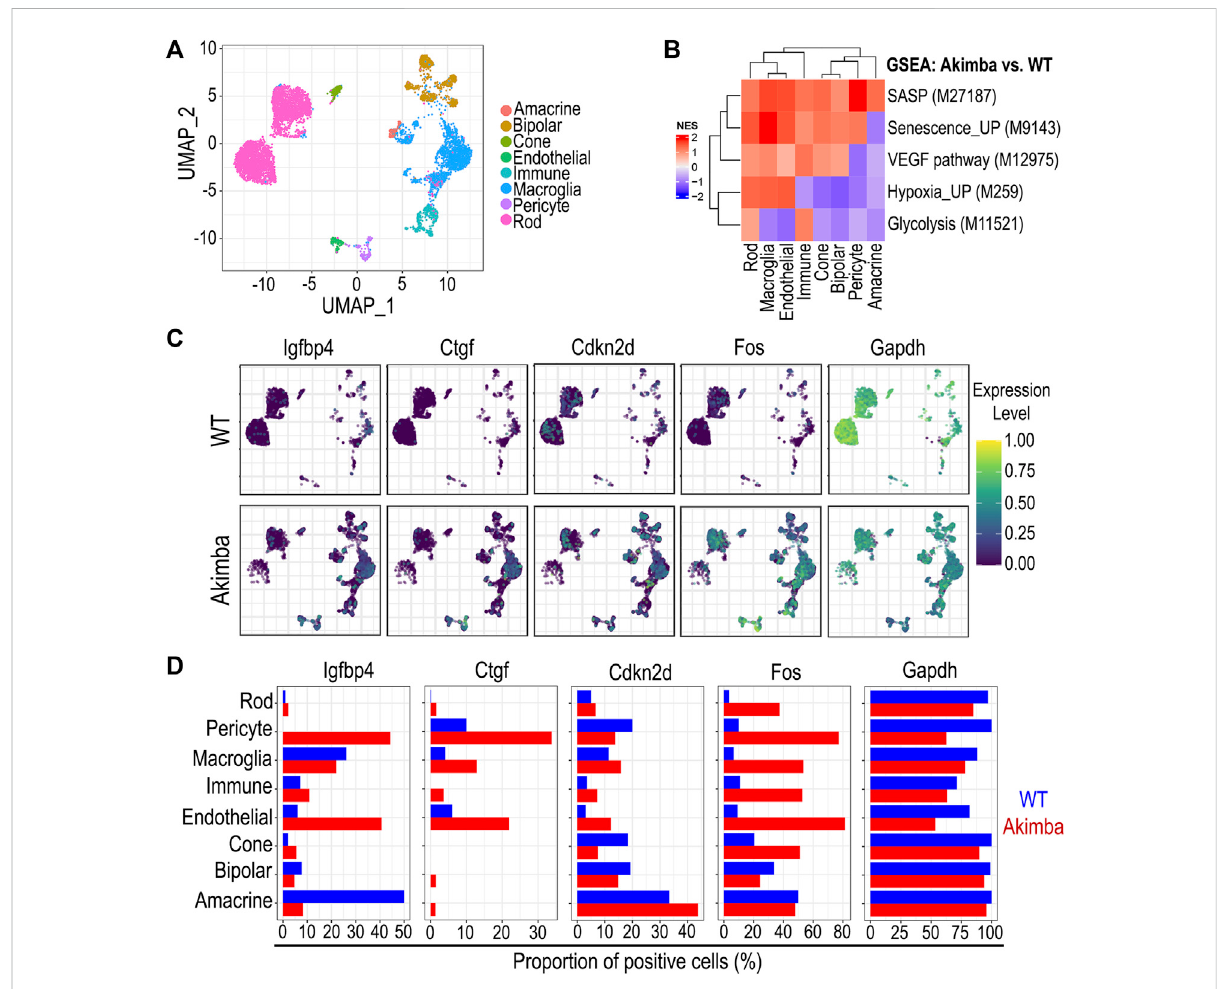
FIGURE 5 Single Cell RNA sequencing analysis of the Akimba mouse model for diabetic retinopathy. (A) Clustering of retinal cells to distinguish cell types. (B) Gene set enrichment analysis comparing diabetic Akimba retinas vs. wild type controls per cell type. (C) Expression level for genes from SASP, senescence, and glycolysis signatures to highlight differences at transcript level. (D) Bar plots quantifying proportion of positive cells for transcripts shown in